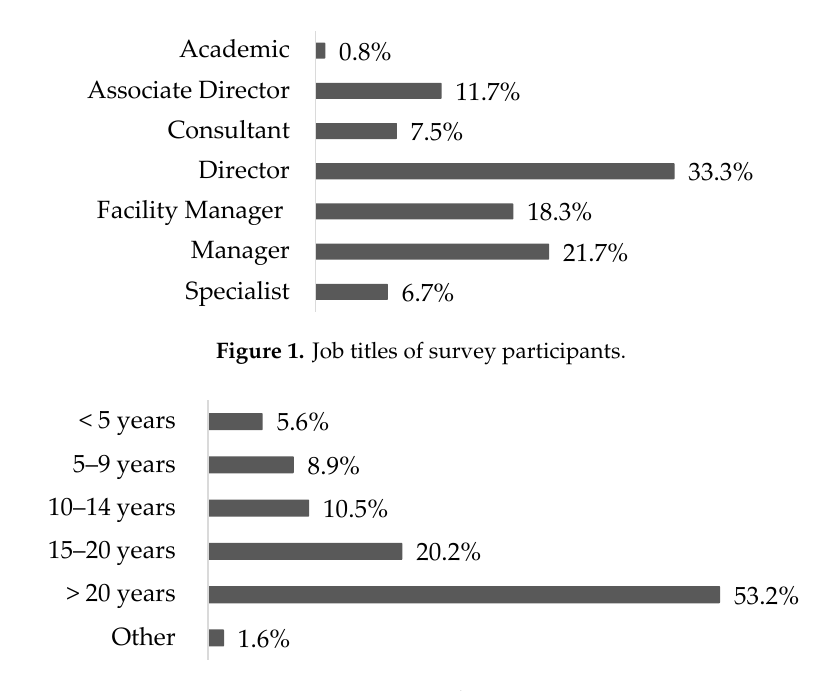
Figure 2. Participants’ work experience in FM.